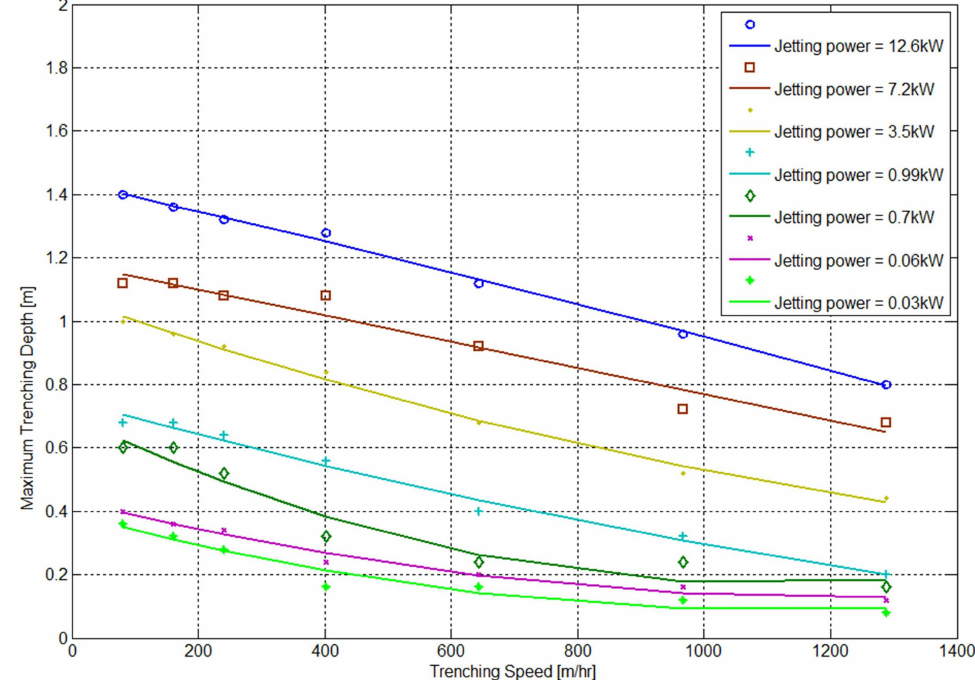
Figure 8. Influence of jetting power and trench speed on the maximum trench